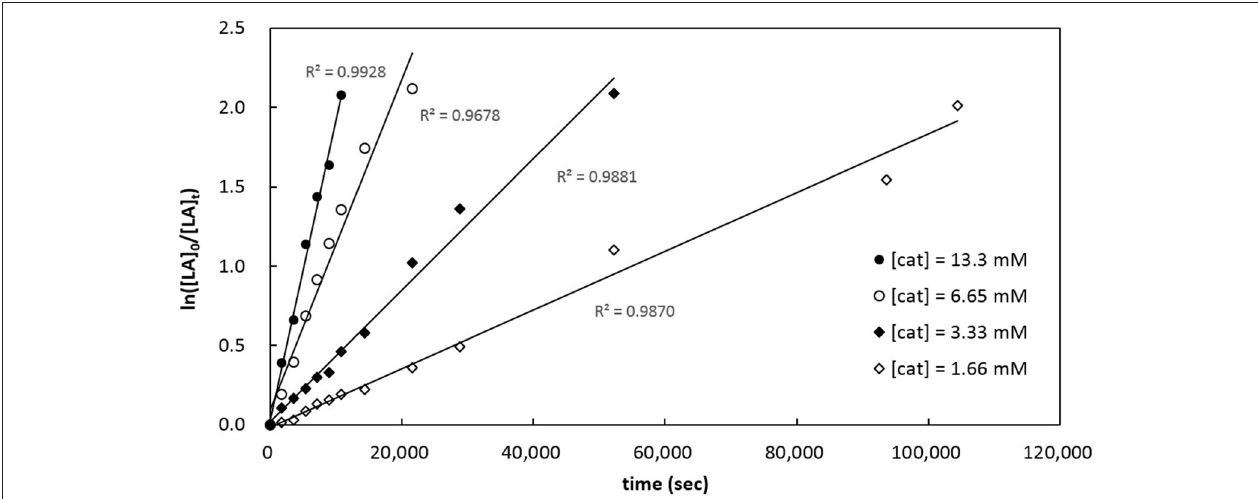
FIGURE 7 | Semilogarithmic plots of rac -LA conversion with time employing catalytic [ 3a ]Al(OCH 2 Ph) in toluene- d 8 at 70 ◦ C. [ rac -LA] 0 = 208mM; i, [cat] 0 = 13.3mM, k obs = 1.89 (7) × 10 − 4 s − 1 ; ii, [cat] 0 = 6.65mM, k obs = 1.04 (7) × 10 − 4 s − 1 ; iii, [cat] 0 = 3.33mM, k obs = 4.15 (15) × 10 − 5 s − 1 ; iv, [cat] 0 = 1.66mM, k obs = 1.85 (6) × 10 − 5 s − 1 .